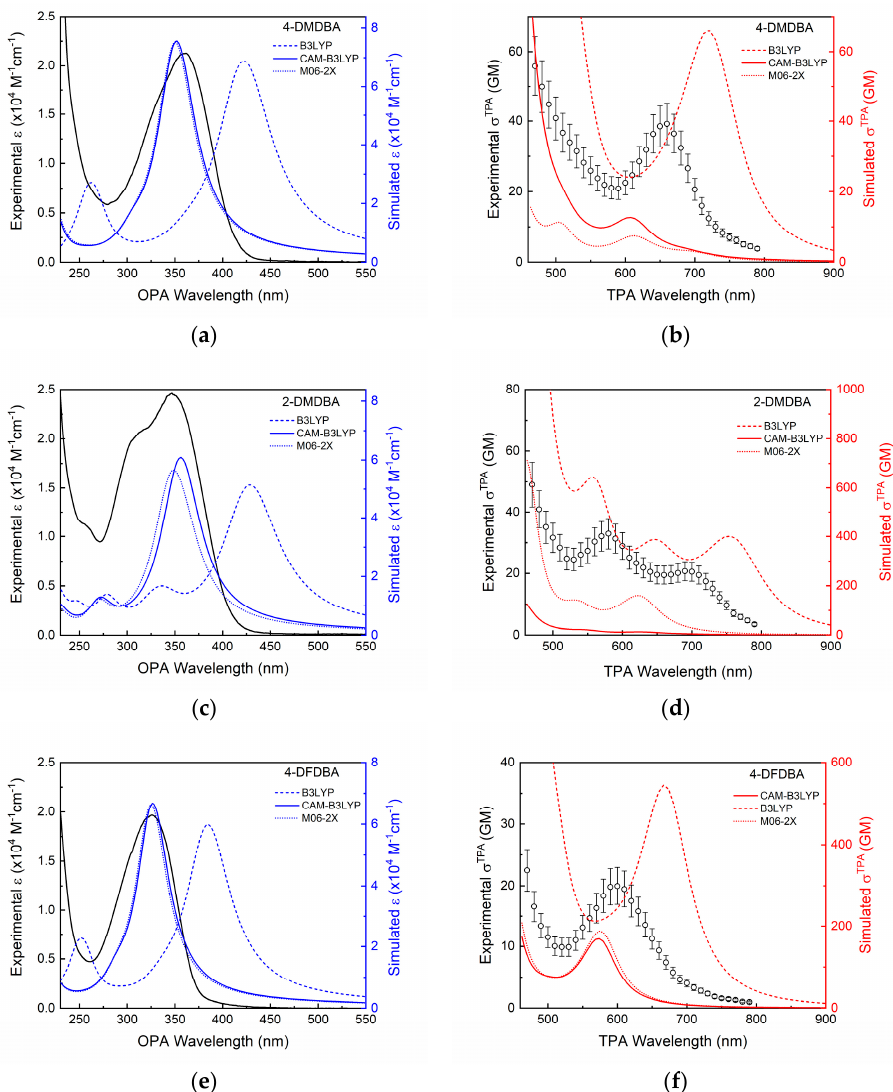
Figure 6. Experimental and simulated one-photon absorption of the DBA derivatives ( a ) 4-DMDBA, ( c ) 2-DMDBA, and ( e ) 4-DFDBA. Experimental and simulated two-photon absorption spectra of the DBA derivatives ( b ) 4-DMDBA, ( d ) 2-DMDBA, and ( f ) 4-DFDBA. Both simulated and experimental spectra were obtained in a dichloromethane medium.